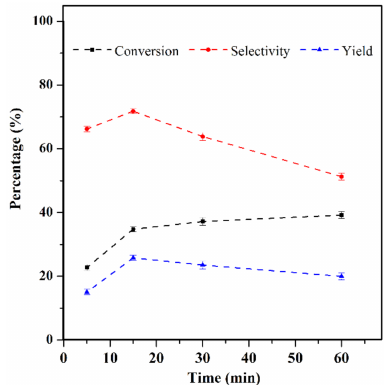
Figure 6. Effect of reaction time in the catalytic performance of microwave-assisted glucose isomer- ization into fructose on 6Mg/NaX catalyst at 90 ◦ C with the triplicate-repeated